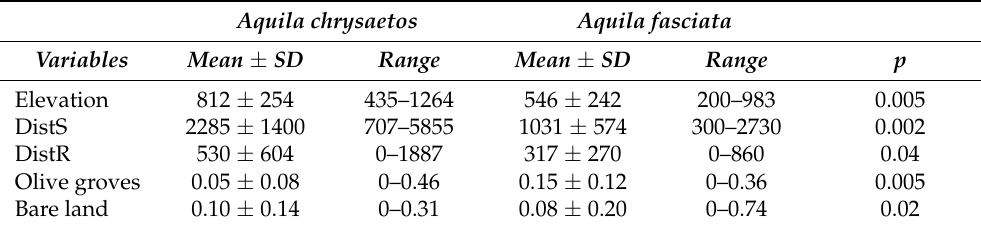
Table 3. Mean values ± SD and range (min-max) of significantly different environmental and habitat parameters of Golden and the Bonelli’s eagle nest sites on overlapping territories in Crete. Aquila chrysaetos Aquila fasciata Variables Mean ±